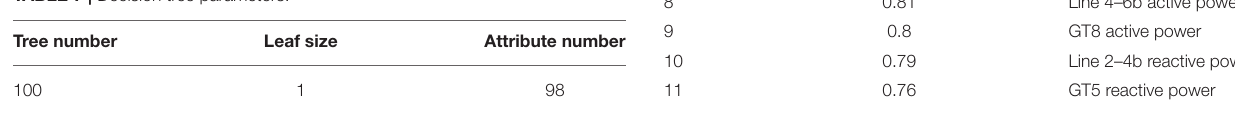
TABLE 7 | Decision tree parameters.